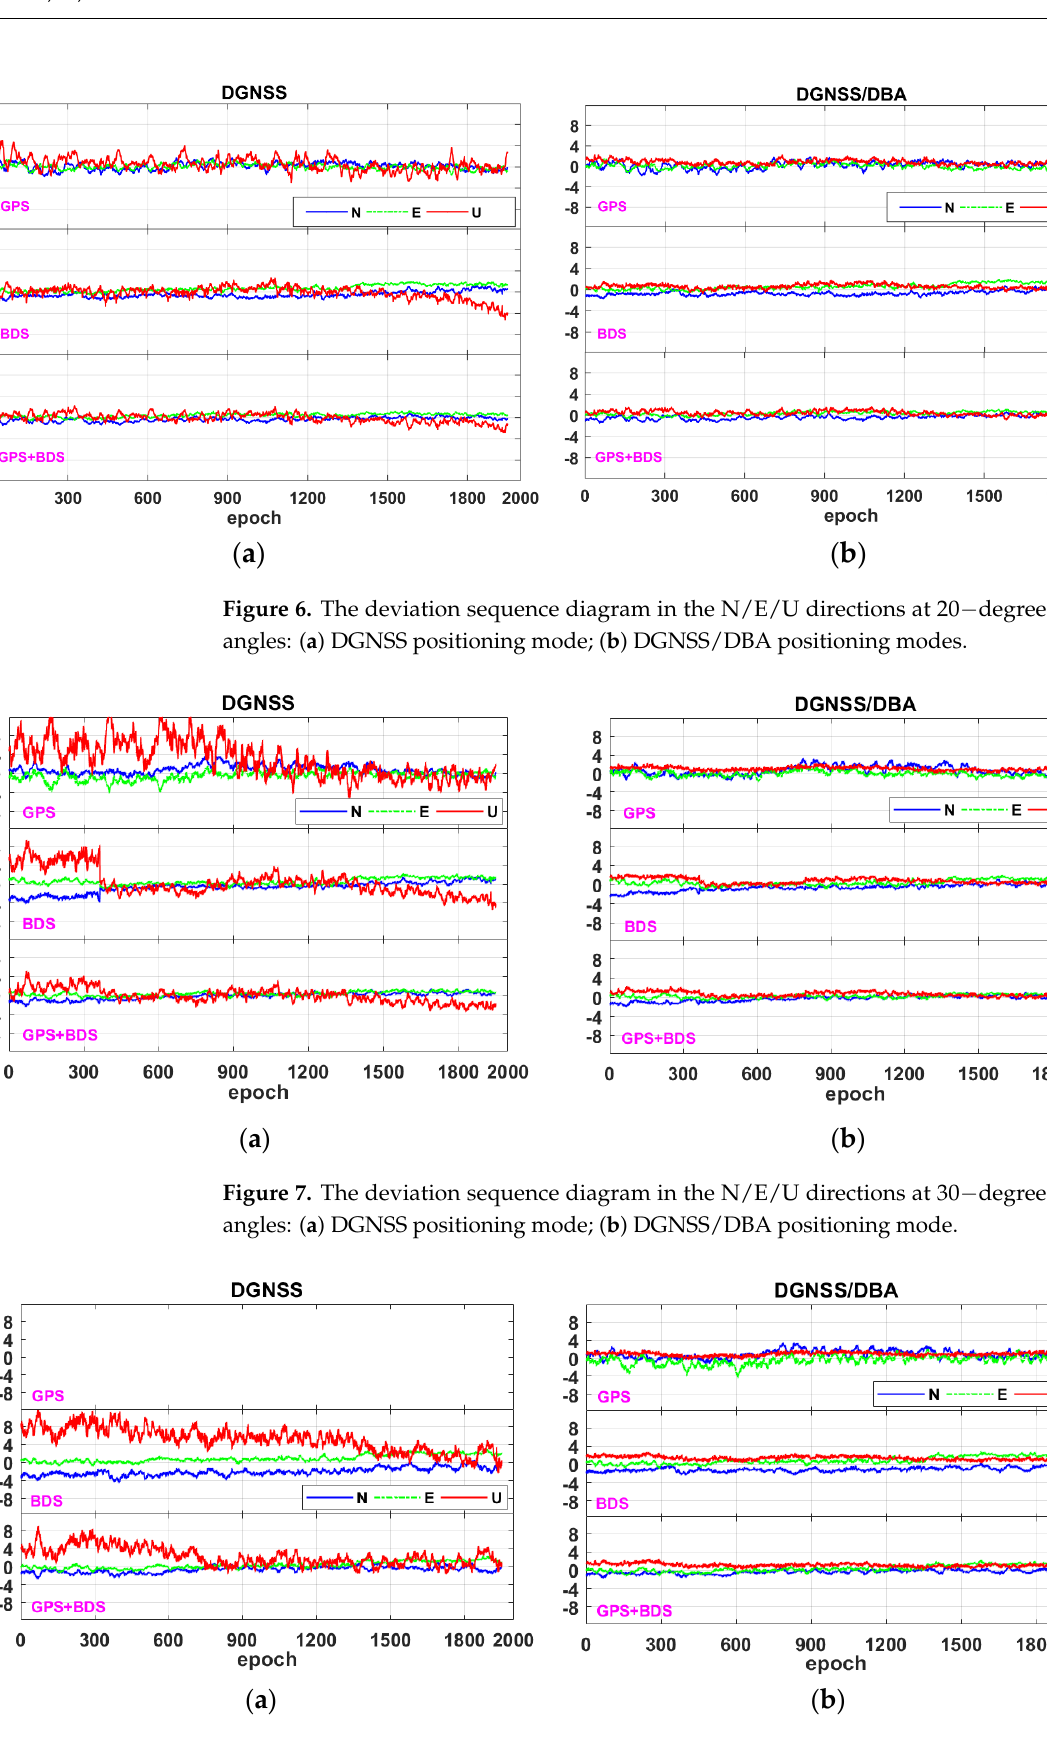
Figure 5. The deviation sequence diagram in the N/E/U directions at 10 − degree elevation mask an-